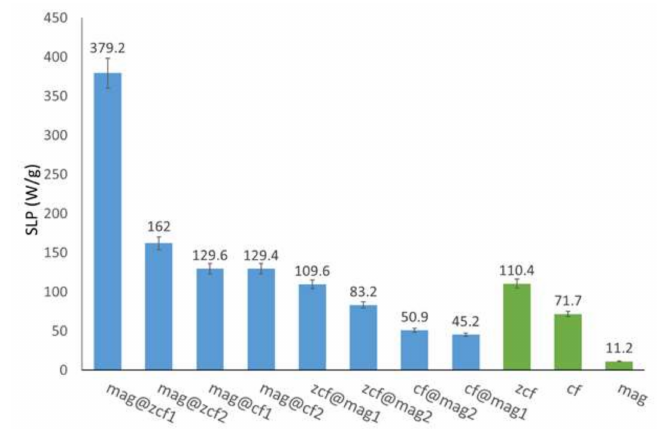
Figure 5. Specific loss powers ( SLPs ) of core nanoparticles and bi-magnetic core-shell MFNs under alternating magnetic field (AMF) with a magnetic field of strength 50 kA / m and frequency 97 kHz.